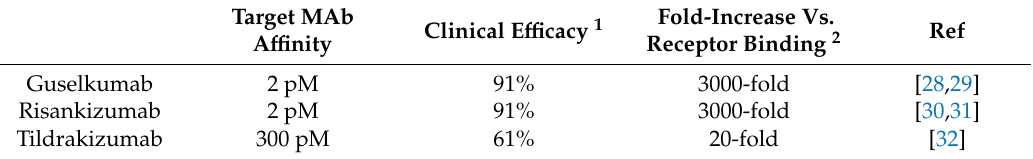
Table 1. Association of IL-23-targeting monoclonal antibody (MAb) a ffi nity with clinical e ffi cacy.